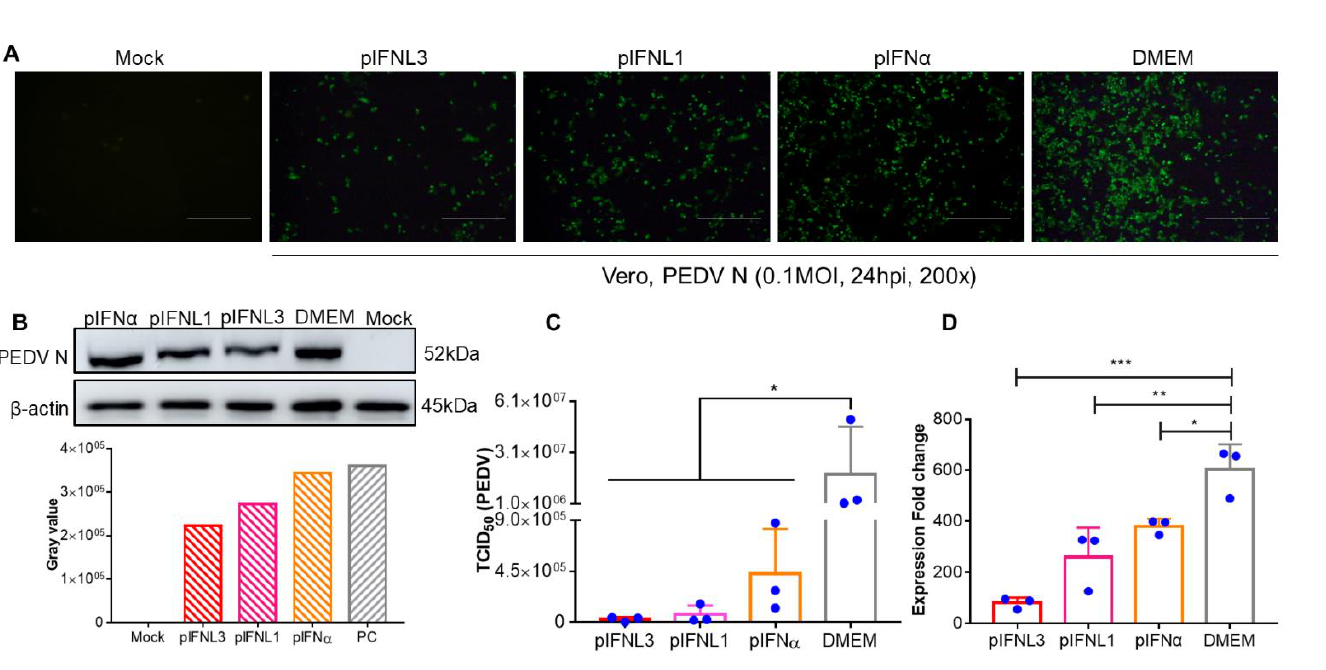
Figure 4. Antiviral activities of pIFNLs against PEDV in Vero; pIFNα served as the control. ( A ) Analysis of the antiviral activities of pIFNLs by IFA. The scale bar corresponds to 150 μm. Using the PEDV N protein, specific antibodies as the primary antibodies, and FITC-labeled goat anti-rabbit IgG (H + L) as the secondary antibody, the virus protein was detected. ( B ) Analysis of antiviral activities of pIFNLs by WB. Using the PEDV N protein, specific antibodies as the primary antibodies, and HRP-labeled goat anti-rabbit IgG (H + L) as the secondary antibody, the virus protein was detected. ( C ) Analysis of the antiviral activities of pIFNLs by TCID 50 . ( D ) Analysis of antiviral activities of pIFNLs by qPCR. *, p < 0.05; **, p < 0.01; ***, p < 0.001.